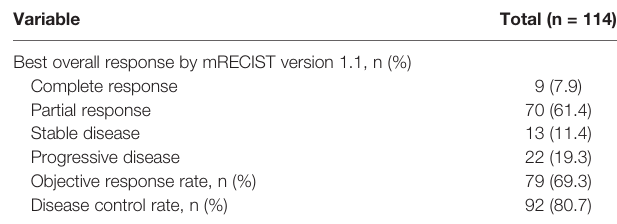
TABLE 2 | Best tumor response of the 114 patients.